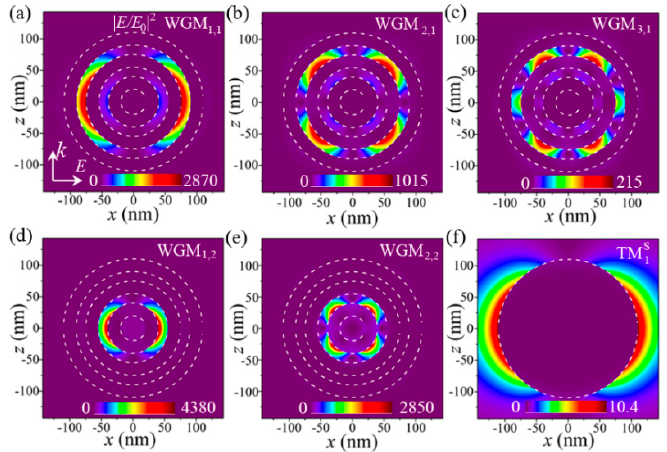
Figure 3. The electric ‐ field intensity (| E/E 0 | 2 ) distributions at k–E ( z ‐ x ) plane for WGM 1,1 ( Fano I ) ( a ), WGM 2,1 ( Fano II ) ( b ), WGM 3,1 ( Fano IV ) ( c ), WGM 1,2 ( Fano III ) ( d ), and WGM 2,2 ( Fano V ) ( e ) in the spherical HMM cavity and the sphere plasmon mode ( TM 1s ), supported by a solid Ag nanosphere ( f ), respectively. Dashed circle lines indicate the interfaces of the silver/dielectric or silver/air. To accurately obtain the characteristics of the resonant modes, the calculated extinc ‐ tion efficiency spectrum is fitted in the vicinity of the FR by using a typical Fano formula: F ( ε ) = σ bg + σ 0 ( q + ε ) 2 / (1 + ε 2 ), where σ bg and σ 0 are the background and normalized ex ‐ tinction, ε = 2( λ − λ res ) / Г with λ res and Г are the resonant wavelength and linewidth of the resonances, and q is the so ‐ called Fano parameter, which describes the degree of asym ‐ metry [3]. Figure 4 shows three examples of such a Fano fitting for the three lowest ‐ order WGMs induced FRs with different line profiles, e.g., WGM 1,1 (asymmetric lineshape, Fig ‐ ure 4a), WGM 2,1 (symmetric lineshape, Figure 4b), and WGM 1,2 (Fano lineshape, Figure 4c). It is obviously seen from Figure 4 that the fitted curves (olive lines) are all in good agreement with the theoretical spectra (red lines) for three different lineshapes, revealing a precise fitting to the FRs. It is also seen from Figure 4 that the linewidths as narrow as 7.4 ~ 21.7 nm are theoretically predicted for the observed FRs. It should be pointed out that the mul ‐ tiple FRs generated by the “symmetry breaking” mechanism in plasmonic nanostructures usually have broad linewidths and need precisely controlled interparticle separation (on the order of several tens of nanometers) [22,24,49]. The linewidths of multiple FRs pro ‐ duced by the plasmonic dielectric ‐ waveguide coupling mechanism can be largely de ‐ creased to ~2 nm due to the non ‐ radiative feature of the dielectric waveguide modes [29]. However, the features of planar structures, together with the relatively large vertical thickness, (the excitation of waveguide modes requiring the vertical thickness of dielectric layer larger than a critical value) are unfavorable for the device miniaturization [1]. Compared with the above two mechanisms, our proposed spherical HMM cavity simultaneously has the characteristics of small device size (deep ‐ subwavelength for three ‐ dimensional) and the multiple sharped plasmonic WGMs, which are due to the large effective refractive index and the highly localized feature of resonant energy (revealing low radiative loss, Figure 3), respectively [46]. In addition, the Fano parameter ( q ), as small as 0.02, is ob ‐ tained for WGM 2,1 , revealing the symmetric lineshape feature (Figure 4b). The q factor increases to 0.13 for the asymmetric lineshape of WGM 1,1 (Figure 4a). Especially for the typical Fano lineshape, the q factor can reach a relatively large value of 0.84 for WGM 1,2 , as shown in Figure 4c. It should be pointed out that the lineshapes of WGMs displayed on the extinction efficiency spectrum arise from the near ‐ field coupling between the WGMs and the corresponding sphere plasmon modes. For example, the symmetric line ‐ shape of WGM 2,1 (Figure 4b) and the asymmetric lineshape of WGM 1,1 (Figure 4a) result from the weak near ‐ field coupling because of a large resonant energy difference between the WGM 2,1 /WGM 1,1 and the sphere plasmon modes (Figure 2b). Meanwhile, for WGM 1,2 , its resonant wavelength coincides with the extinction peak of TM 1S (Figure 2b), and thus